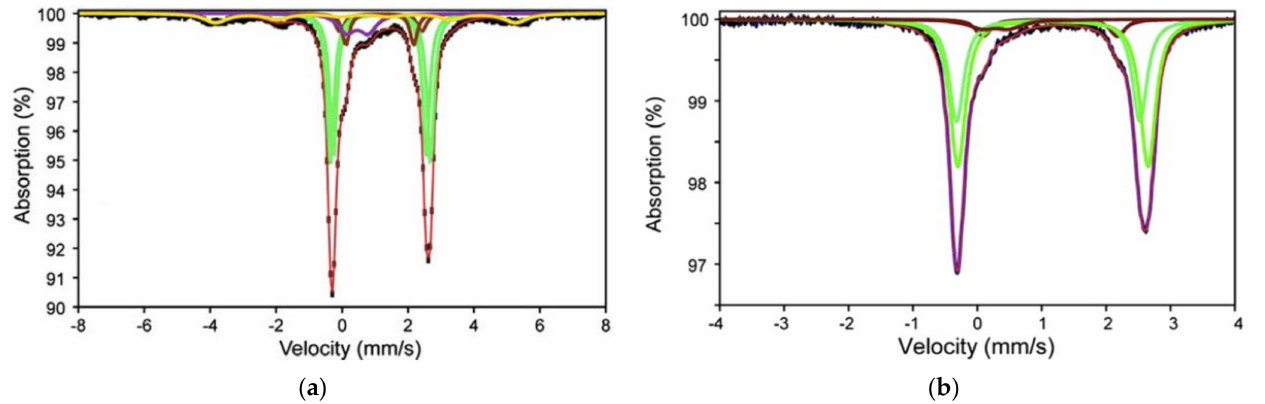
Figure 7. Room temperature Mössbauer spectra of R chondrite LAP 04840 R6: the bulk sample ( a ) and extracted olivine and orthopyroxene ( b ). Indicated components are the results of the fits. Adapted from Reference